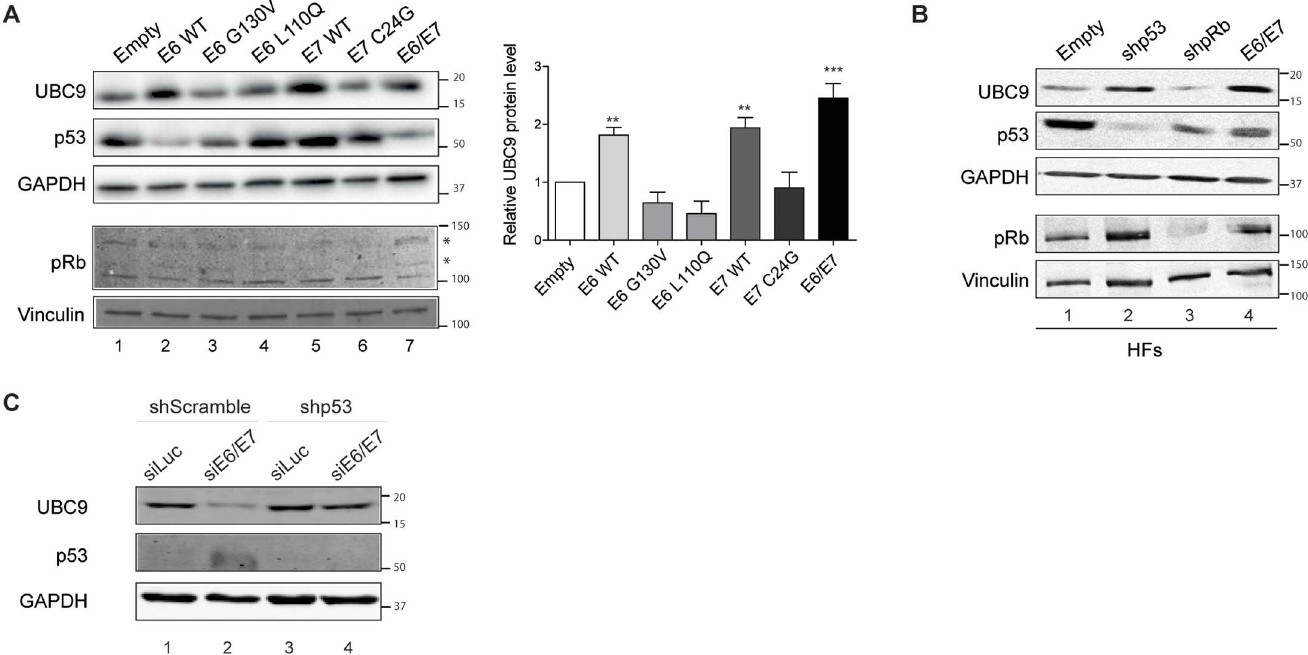
Fig 5. p53 mediate UBC9 accumulation triggered by HPV16 E6/E7. (A) Left: Representative WB of HKs transduced with the indicatedrecombinant retroviral vectors and analyzedby immunoblotting using anti- UBC9 antibody. Right: quantification of the protein bands intensities, standardized to GAPDH levels. Data are expressedas fold over the empty-transduced HKs. Bars represent means ± SEM of at least n = 9 biological replicates. * P < 0.05; ** P < 0.001; *** P < 0.0001(Kruskal–Wallis one-wayANOVA with Dunn’spost hoc test). p53 and pRb are reported as control for E6, E7, and mutants expression, respectively.Asterisks mark the phosphorylated forms of pRb. (B) Representative WB of HFs transduced with the indicatedretroviral vectors and analyzedby immunoblotting using anti- UBC9, -p53, pRb antibodies.GAPDH and Vinculinare reportedas loadingcontrol. n = 3 biological replicates. (C) Representative WB of Caski cells transduced with shScramble or shp53, as indicated, and treated with control siRNA (siLuc) or with siE6/ E7 as describedin Materials and Methods. Samples were analyzedby immunoblotting using anti- UBC9 and anti-p53antibodies.GAPDH is reportedas loading